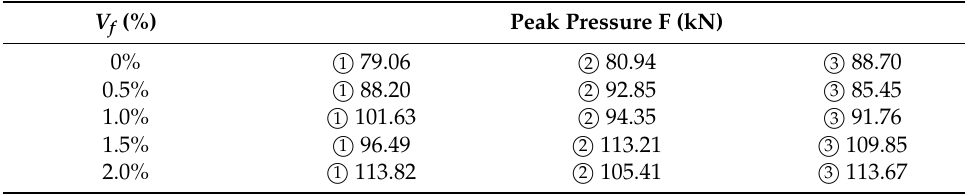
Figure 4. Quasi-static experimental results: ( a ) SFRC basic mechanical parameters; ( b ) The relation- ship between the dimensionless parameters of SFRC and steel fiber content; ( c ) The damage process of SFRC with different steel fiber content under uniaxial compression. Table 2. Uniaxial compression test results of spindles with different steel fiber